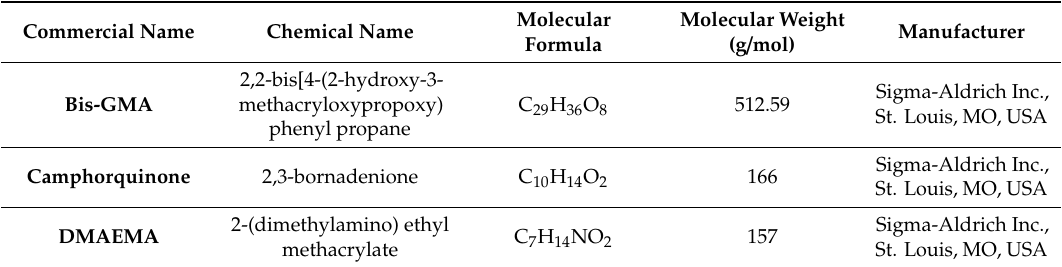
Table 2. Chemical characteristics of the materials used to prepare Bis-GMA